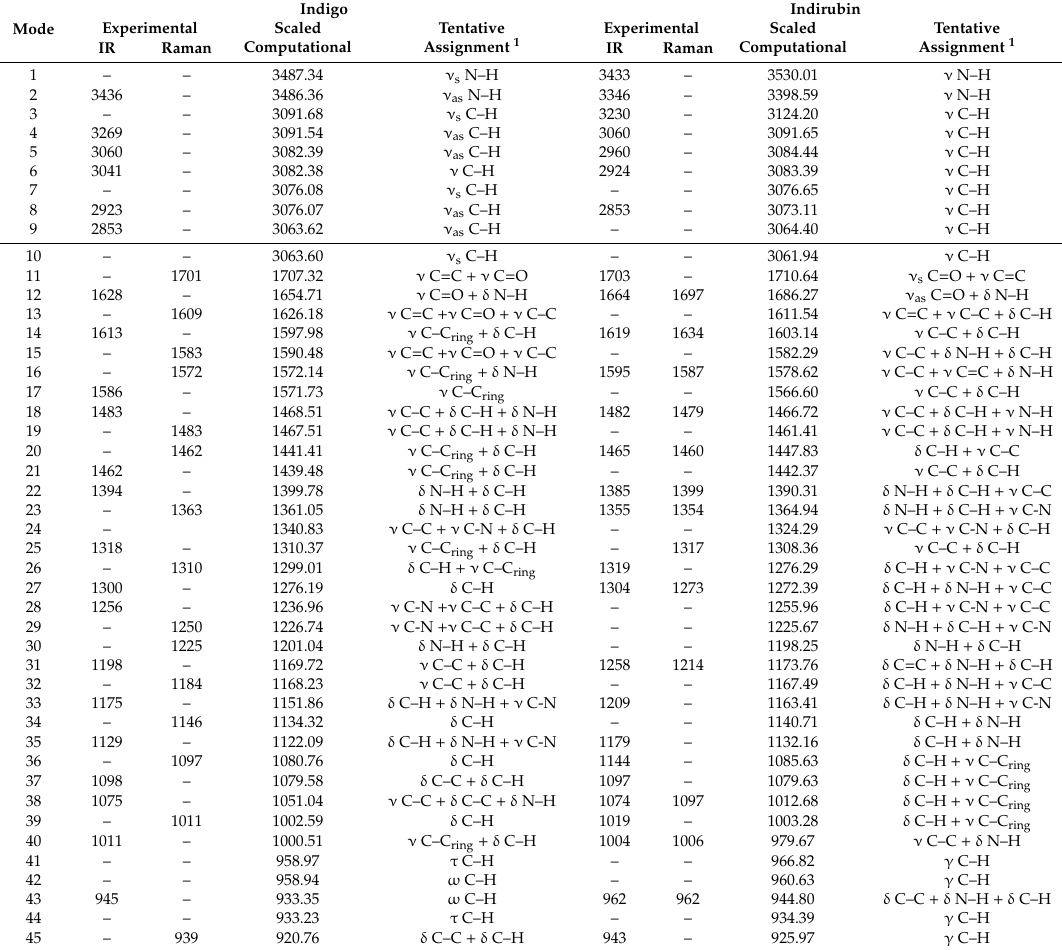
Figure 5. Infrared spectra ( a ) and Raman spectra ( b ) of indigo and indirubin. Table 3. Experimental and computational vibrational wavelengths and assignments for indigo and indirubin at B3LYP/6-311G(d,p).